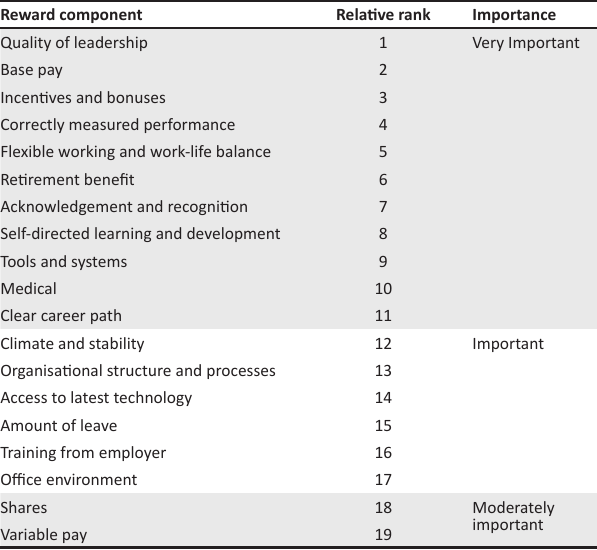
TABLE 10: Relative importance of reward components. Reward component Relative